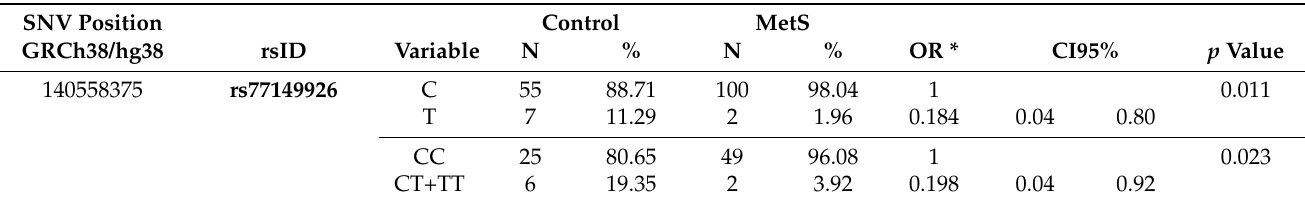
Table 2. Selected variants of the UCP1 gene with the different frequencies of alleles and genotypes between controls and MetS